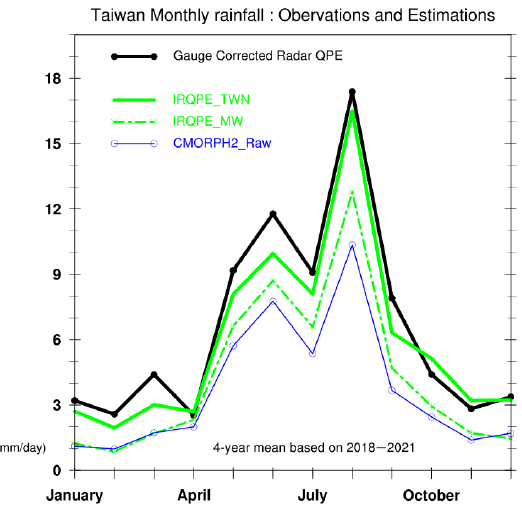
Figure 12. The monthly mean rainfall for Taiwan land area from 3 satellite precipitation estimates (solid green: IRQPE_TWN, dashed green: IRQPE_MW, blue: CMORPH2) and the reference ground truth (black: QPESUMS).